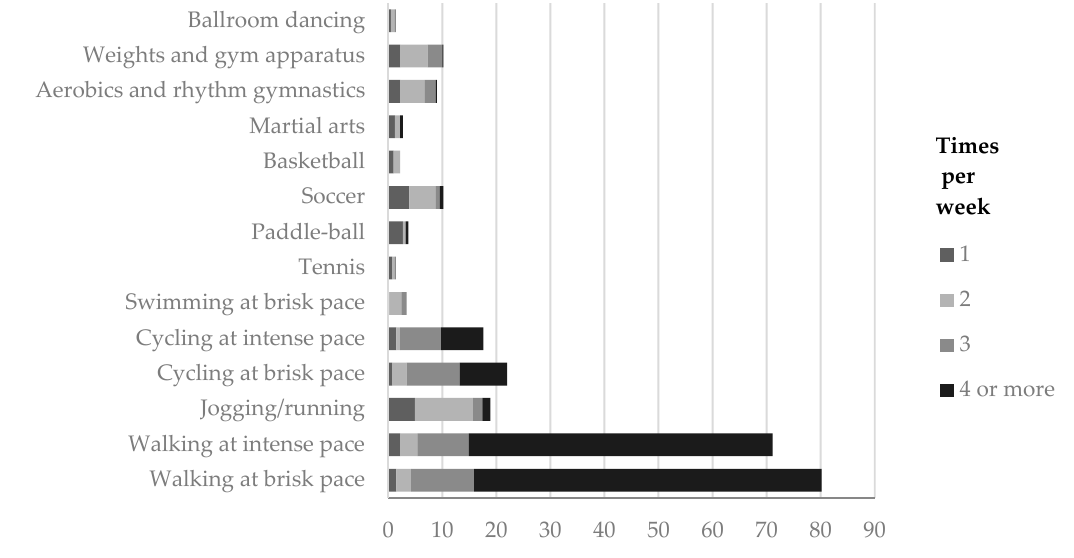
Figure 1. Types of LTPA of at least 30 min.